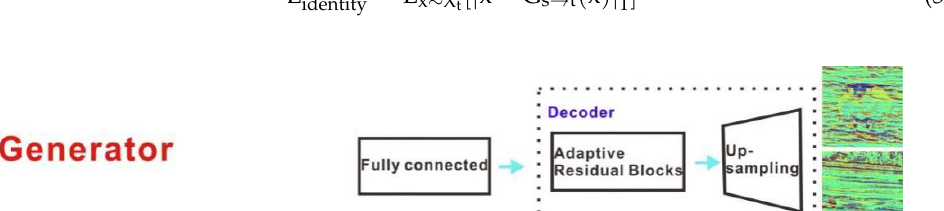
In the mapping process from source domain s to target domain t , G s→t (x) refers to the false data generated from source domain s . The probability that the discriminator will still determine the false data generated by the generator in the source domain as false data is given by 1 − D t (G s→t (x)) . D t (x) is the probability that the discriminator will determine the true data as true data, and the adversarial loss is the sum of the two. Cyclic consistency loss reduced the mapping path from the source to the target domain.